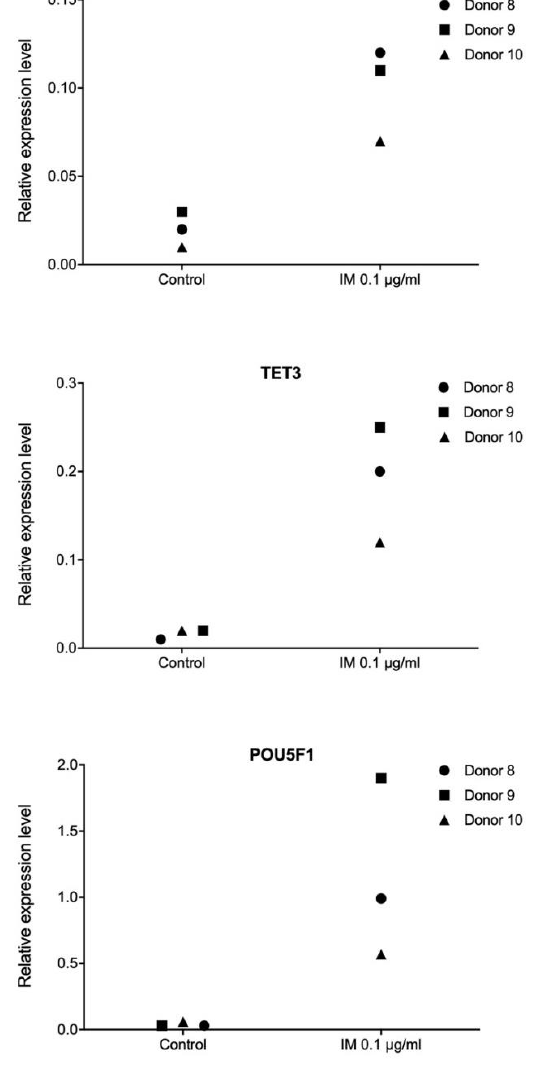
Figure 5. Transcriptional responses of TET1 , TET3 , and POU5F1 to IM at 0.1 µg/mL in primary fibroblast cell cultures. Controls were cultured in the same medium without IM addition. No statistically significant changes were observed (Mann–Whitney U test, p <